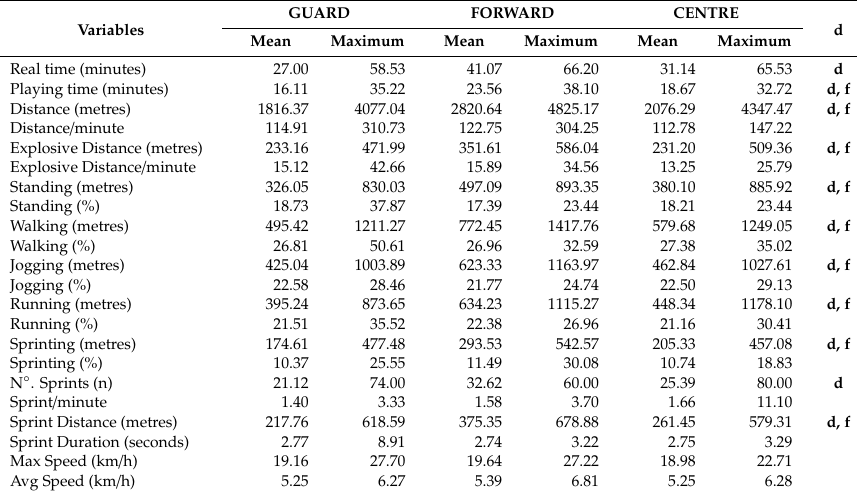
Table 3. Descriptive results by playing